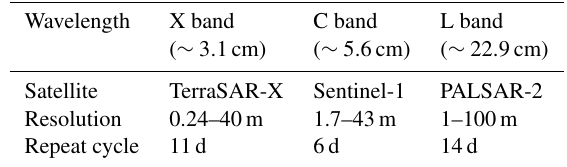
Table 1. Spaceborne SAR